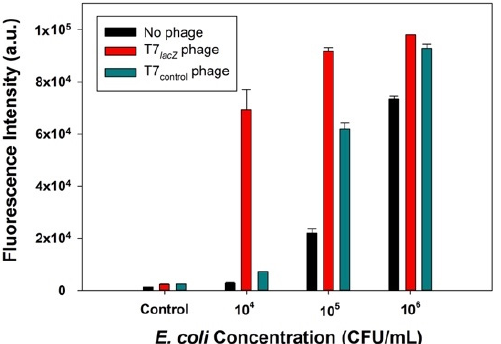
Figure 3. Comparison of the fluorescence intensity measured using T7 lacZ phages (red bars), T7 control phages (green bars), and no phages (dark blue bars). Control group indicates the absence of bacteria in the reaction mixture. The values reflect the average of at least three independent biological replicates and standard deviation is shown as the error